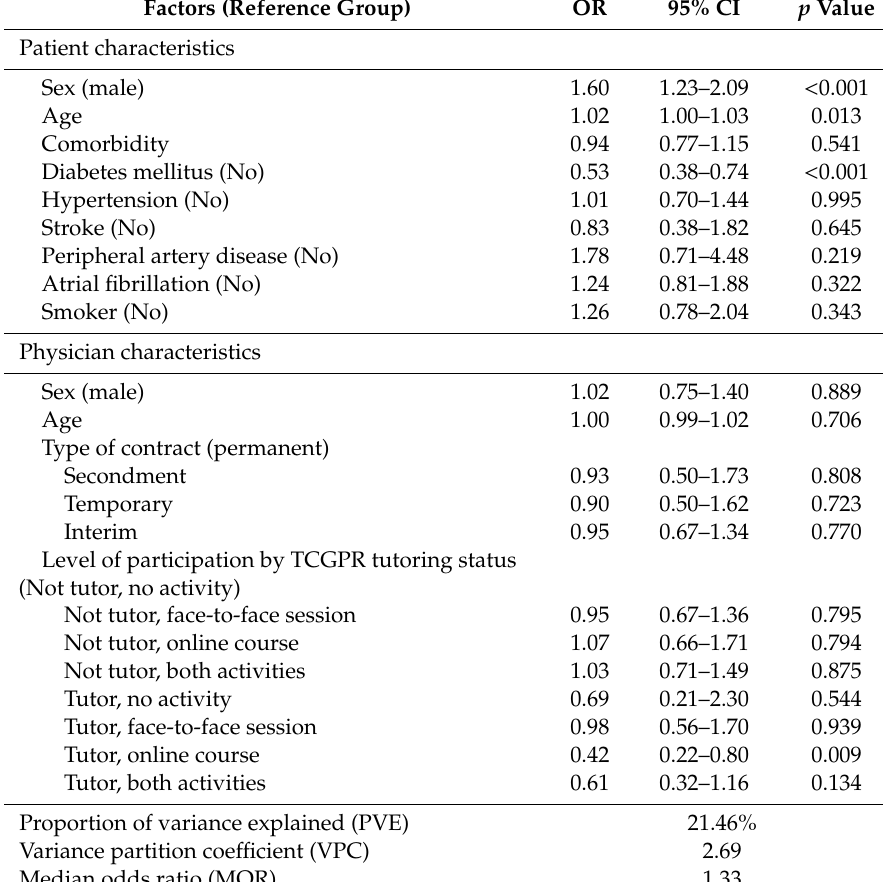
Table 4. Multivariate multilevel analysis showing the association between LDL-C control after Phase 1 of CPG implementation, and the patient and physician characteristics, with the new composite